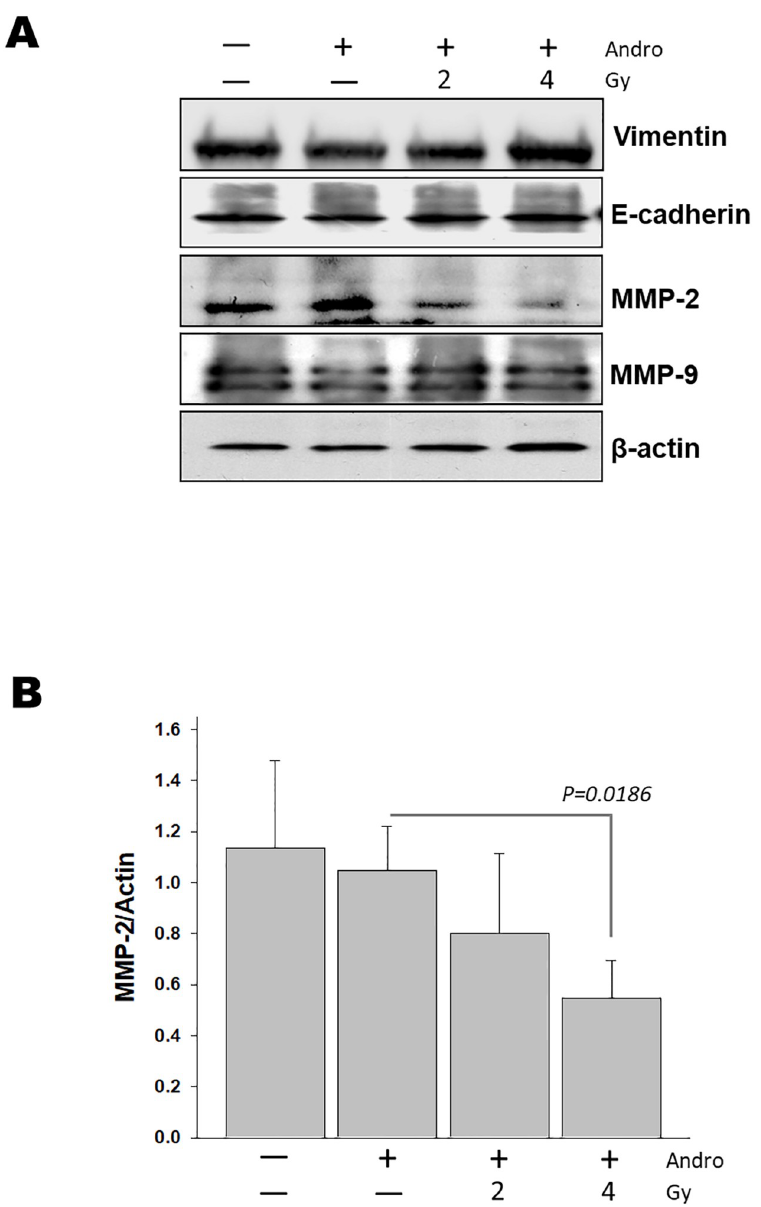
Fig 2. Effects of andrographolide and radiation on the expression EMT-related markers (E-cadherin, vimentin) and matrix metalloproteinases MMP-2 and -9. (A) RAS-transformed cells were treated with 10 uM andrographolide for 6 hours with and without 2 or 4 Gy radiation. After 24 hours, the cells were harvested for preparation of whole-cell protein lysates followed by Western blotting to detect the given proteins. (B) Quantitative analyses of MMP-2 expression evaluated by MMP-2/GAPDH ratio. The results are shown as mean ± SD (n = 3). � p < 0.05 for andrographolide combined with 4 Gy vs. andrographolide alone.